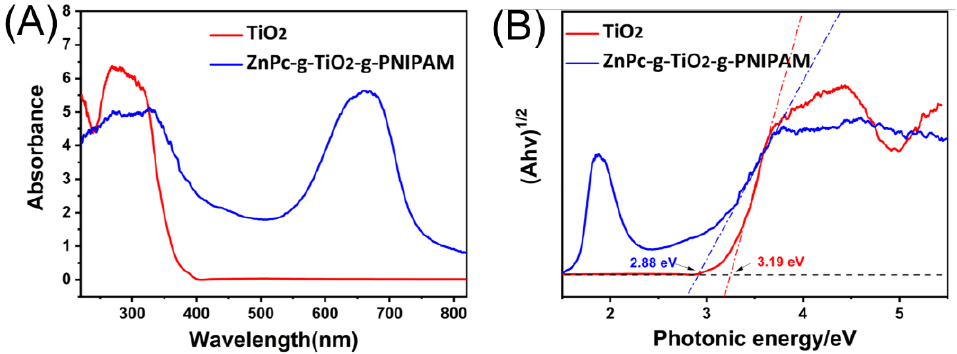
Figure 5. UV-vis diffuse reflectance spectroscopy of TiO 2 and ZnPc- g -TiO 2 - g -PNIPAM ( A ) and the corresponding estimated band gaps of TiO 2 and ZnPc- g -TiO 2 - g -PNIPAM ( B ).